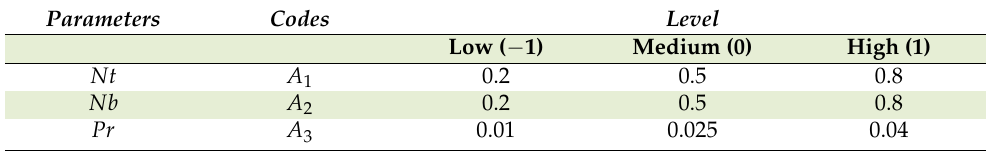
Table 7. Design parameters and